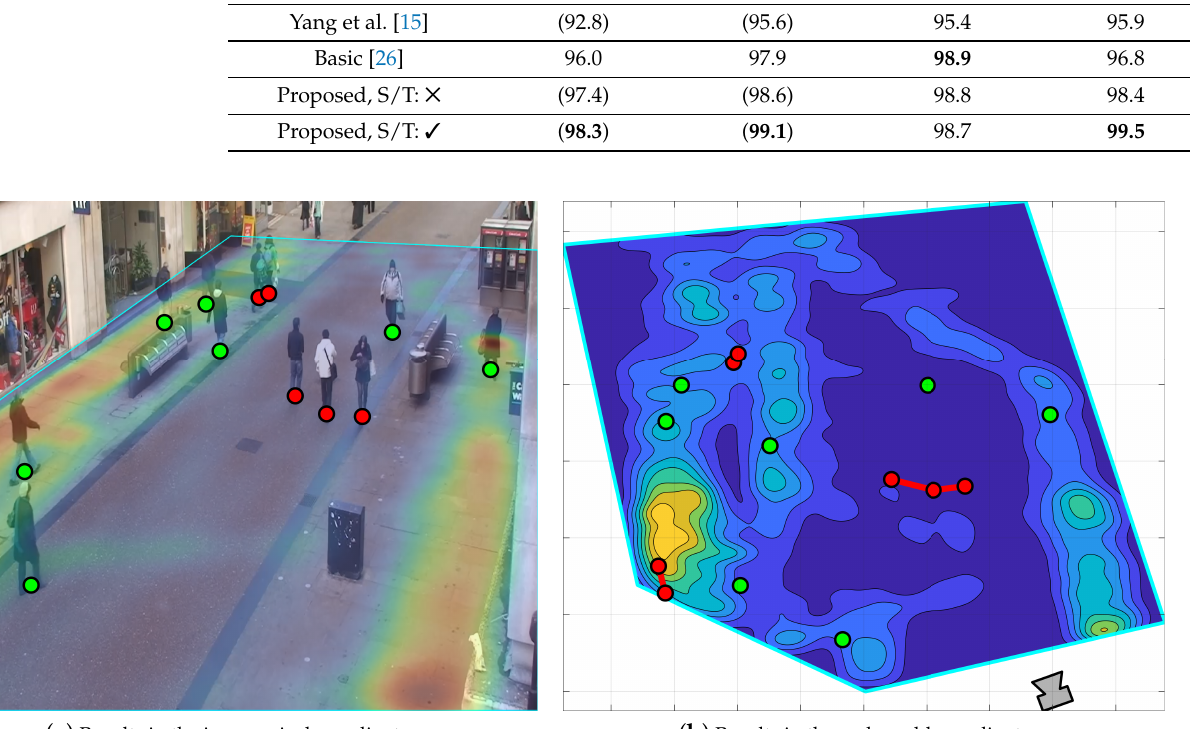
Figure 8. Example social distance violation detection results using frames 1 to 2005 of the OxTown dataset with a 2 m social safety distance. ( a , b ) overlay the detection results with the averaged ODM and CDM,